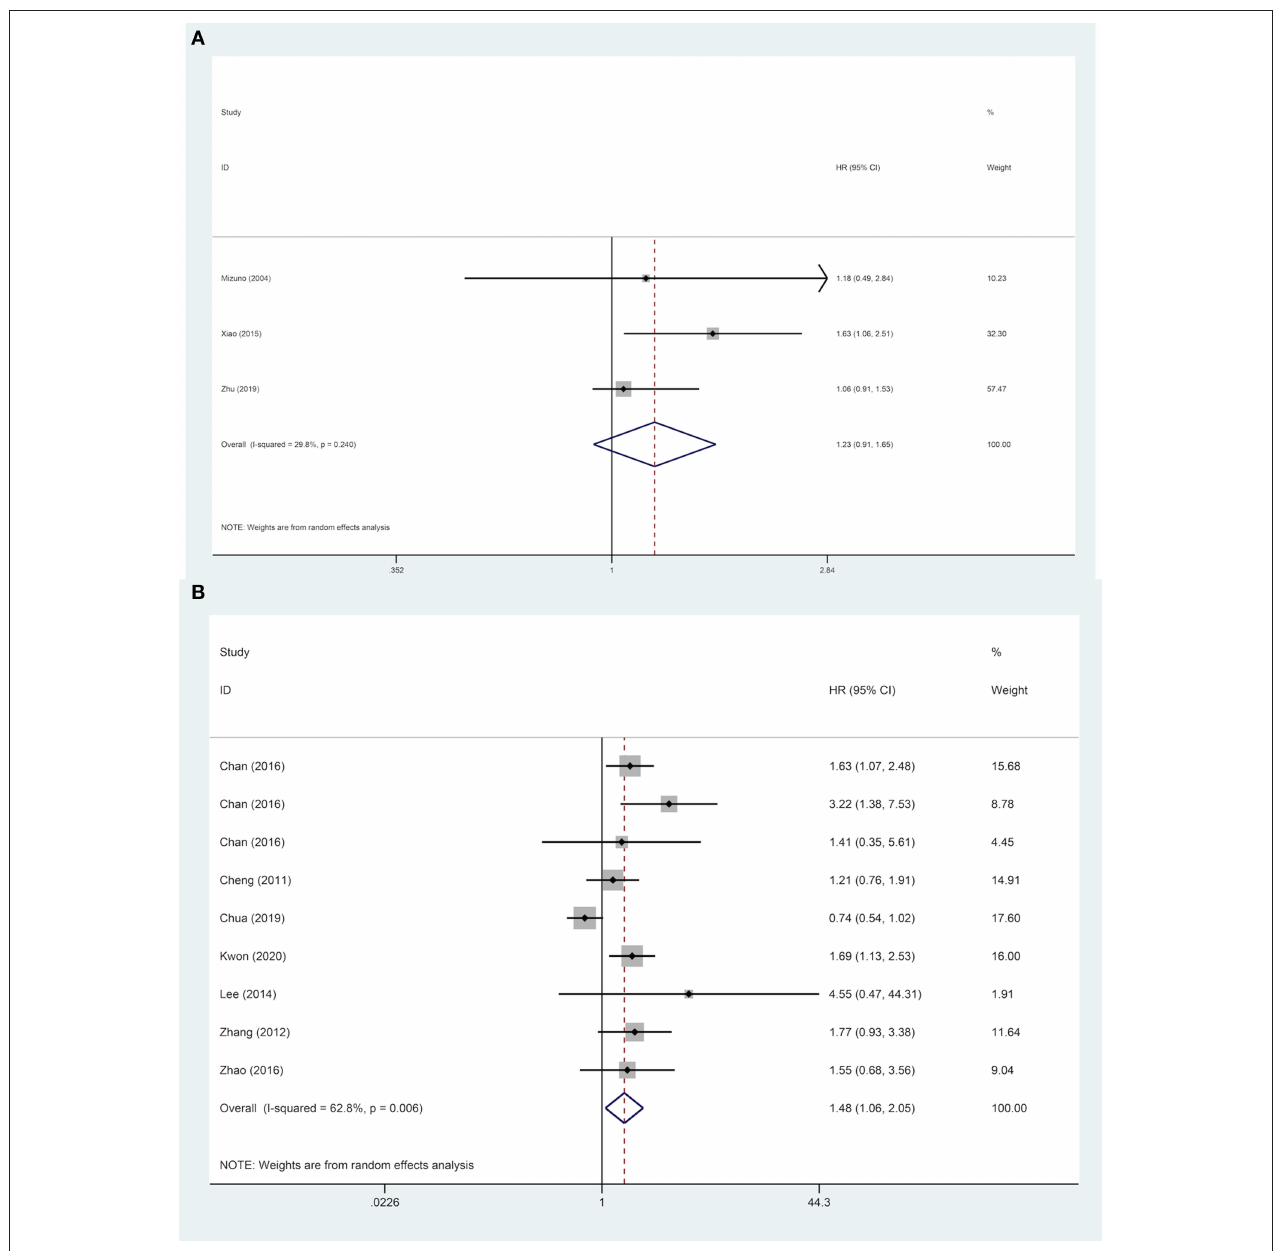
FIGURE 5 | Forest plot of DFS of ruptured hepatocellular carcinoma (HCC) patients with macrovascular invasion after hepatectomy ( A , macrovascular invasion positive, P = 0.170; B , macrovascular invasion negative, P =